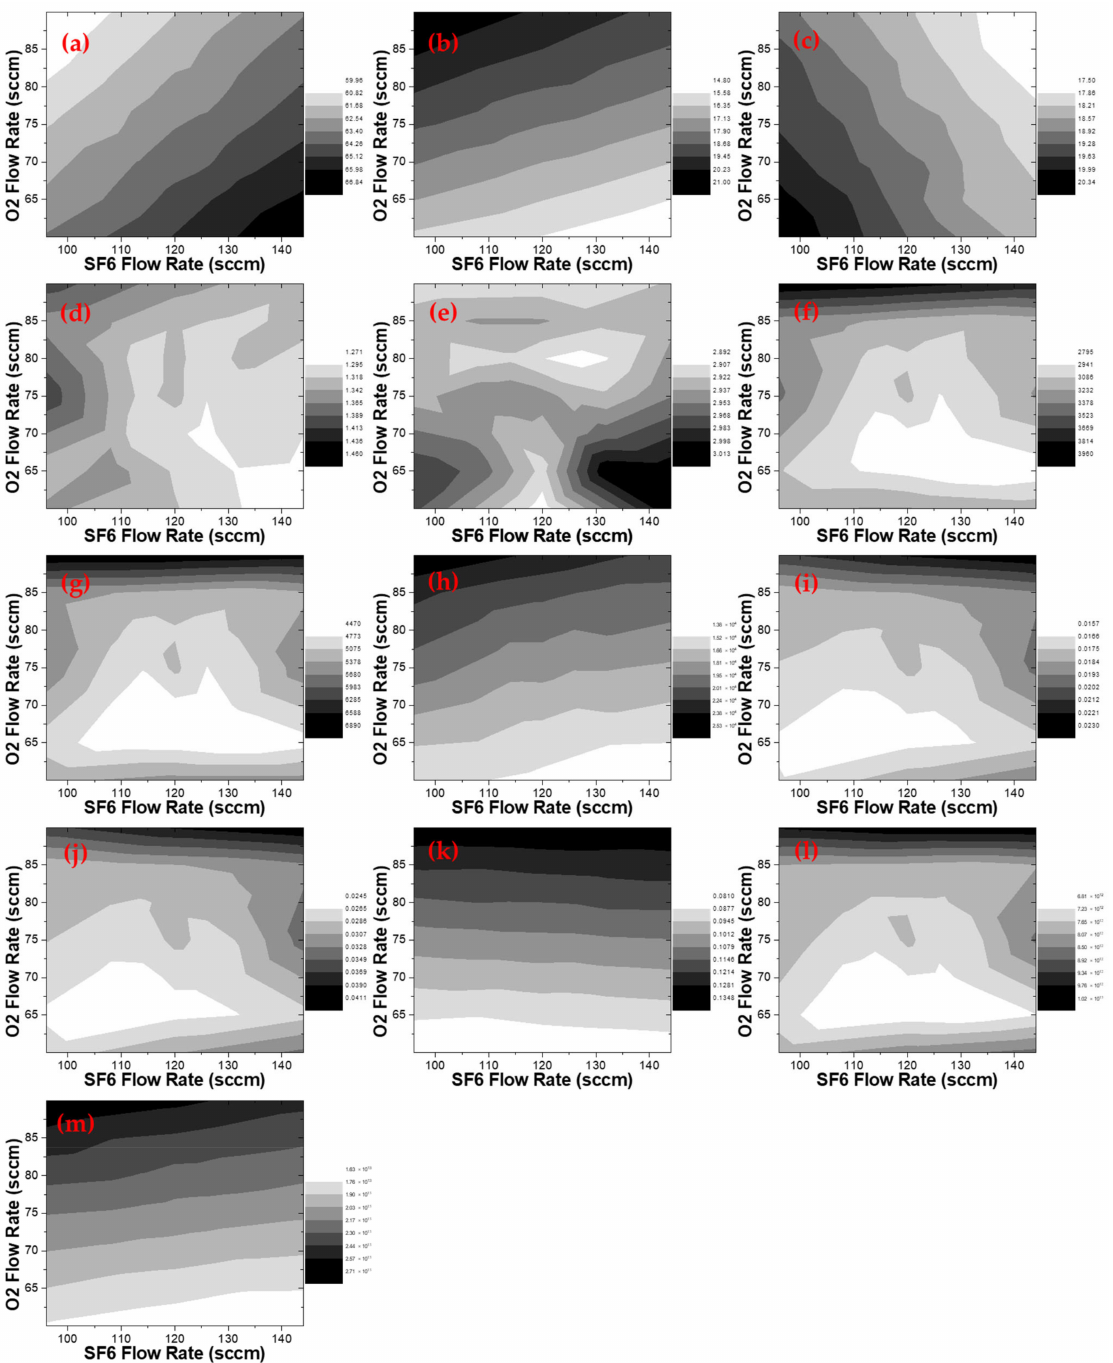
Figure 4. Plasma information variables with varying SF 6 and O 2 flow rates. The error of PI-OES is within 0.3% in one etch process. ( a ) Molar fraction of SF 6 [%]; ( b ) molar fraction of O 2 [%]; ( c ) molar fraction of Ar [%]; ( d ) ne [a.u.]; ( e ) Te [eV]; ( f ) I(F, 685 nm) [a.u.]; ( g ) I(F, 703 nm) [a.u.]; ( h ) I(O, 777 nm) [a.u.]; ( i ) I(F, 685 nm)/I(Ar, 750.4 nm) [a.u.]; ( j ) I(F, 703 nm)/I(Ar, 750.4 nm) [a.u.]; ( k ) I(O, 777 nm)/I(Ar, 750.4 nm) [a.u.]; ( l ) nF [cm − 3 ]; ( m ) nO [cm − 3